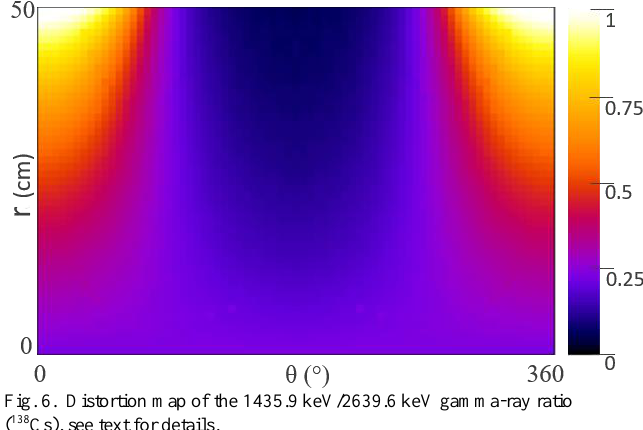
Fig. 6. Distortion map of the 1435.9 keV/2639.6 keV gamma-ray ratio ( 138 Cs), see text for details. Then, the locations corresponding to the measured 138 Cs ratio distortion factor in positions 1 and 2 are determined on the simulated ratio distortion map of Fig. 6. The positions for which the experimental and simulated ratio distortions are in good agreement are represented by the orange and yellow tracks in Fig. 7, respectively for positions 1 and 2, in case of the DU sample. The location of the sample corresponds to the intersection of these tracks and is represented by the blue dot.